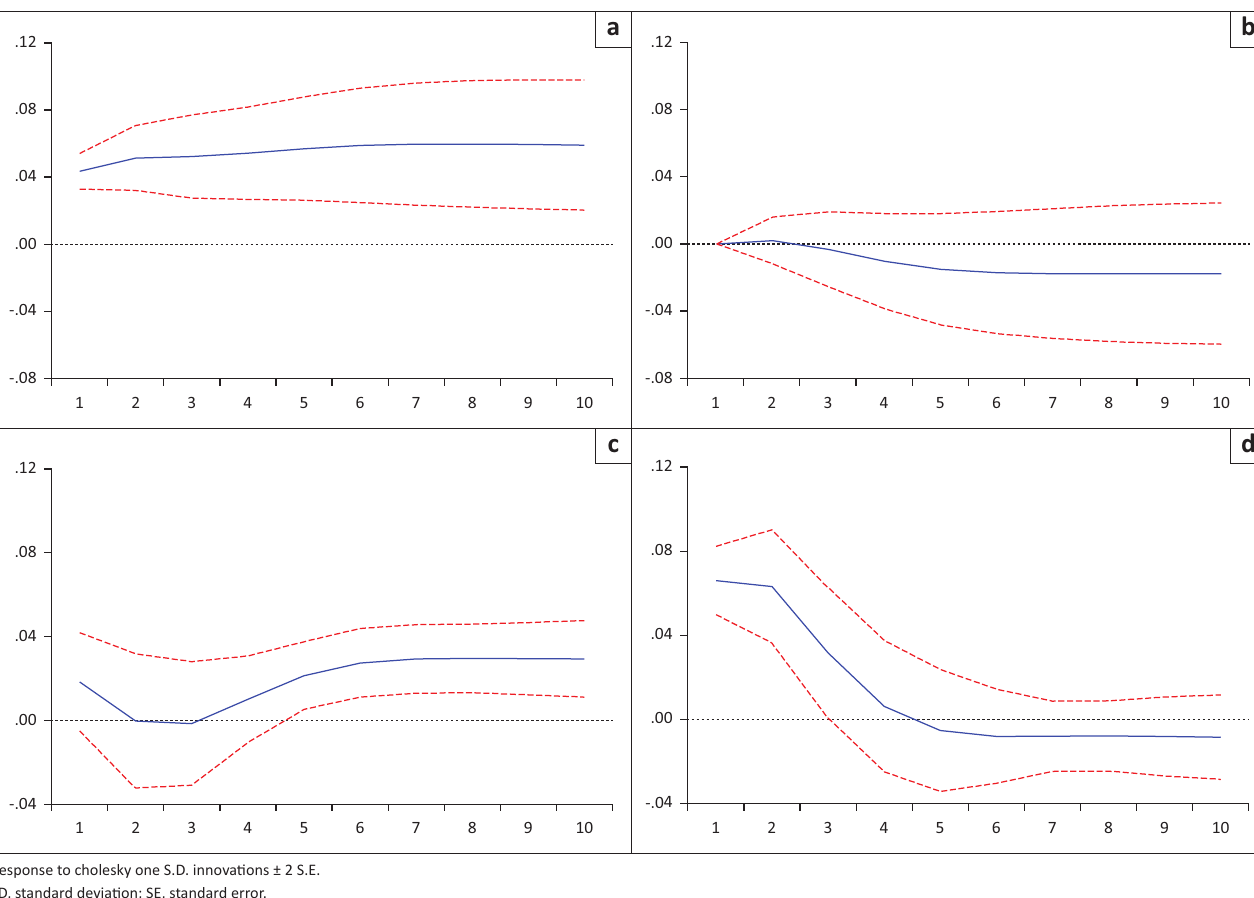
FIGURE 5: Impulse response functions. (a) Response of LOG(GDP) to LOG(GDP), (b) Response of LOG(GDP) to LOG(TPM), (c) Response of LOG(TPM) to LOG(GDP) and (d) Response of LOG(TPM) to